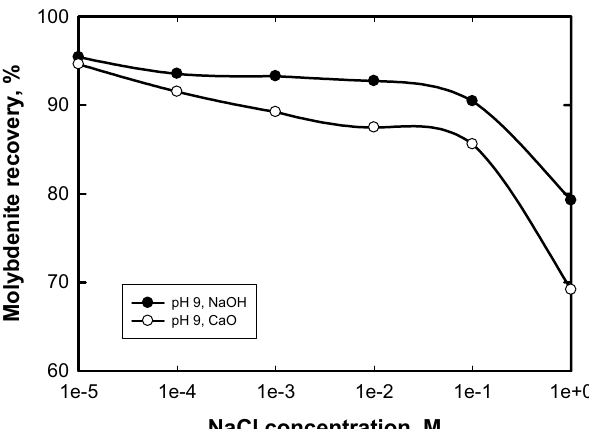
NaCl concentration, Fig. 12 Effect of NaCl concentration on the flotation of molybdenite at pH 9 adjusted either by NaOH or CaO 30) .